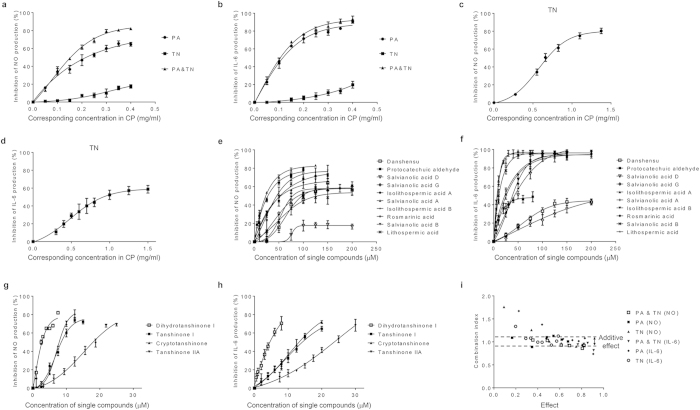
Combination index and dose-dependent inhibition of LPS-induced inflammatory indicator production by single active compounds or compound combinations.RAW264.7 macrophage cells were pretreated with different concentrations of tested samples in the presence of 1 μg/ml LPS for 24 h. Dose-effect curves of PA, TN, and their combinations in inhibition of (a) NO and (b) IL-6 production. Dose-effect curves of TN at higher concentrations in inhibition of (c) NO and (d) IL-6 production. Dose-effect curves of 10 phenolic acids in inhibition of (e) NO and (f) IL-6 production. Dose-effect curves of 4 tanshinones in inhibition of (g) NO and (h) IL-6 production. (i) Combination index. The combination index was calculated using CompuSyn software based on the data of 3 replicates. 0.9 < CI < 1.1 indicated an additive effect. CP: Cardiotonic Pill; PA: combination of 10 phenolic acids; TN: combination of 4 tanshinones; PA&TN: combination of PA and TN.